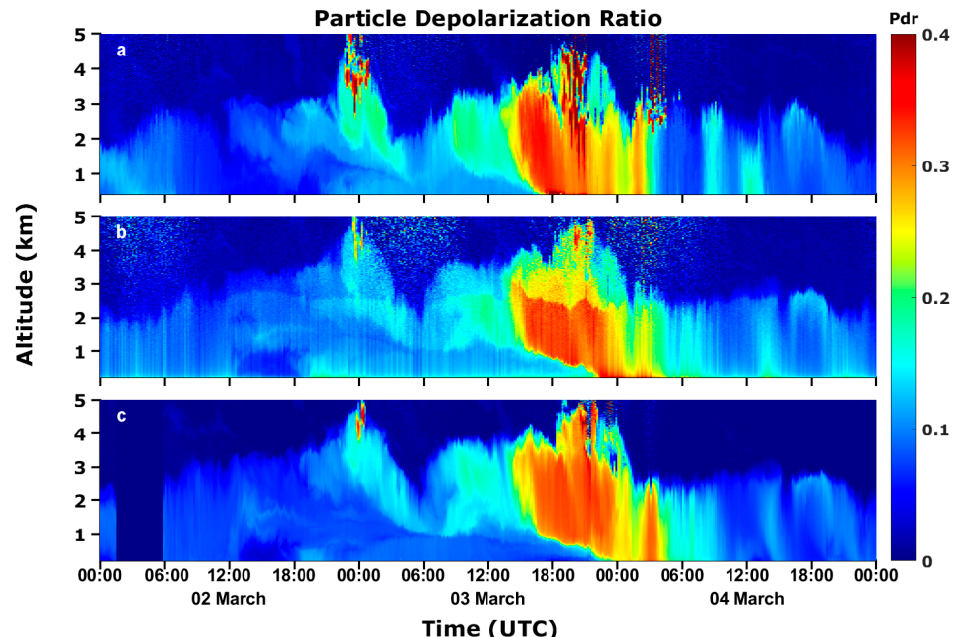
Figure 6. The spatiotemporal distribution of particle depolarization ratios in each region (( a ) Yanqing, ( b ) Haidian, and ( c ) Nanjiao).